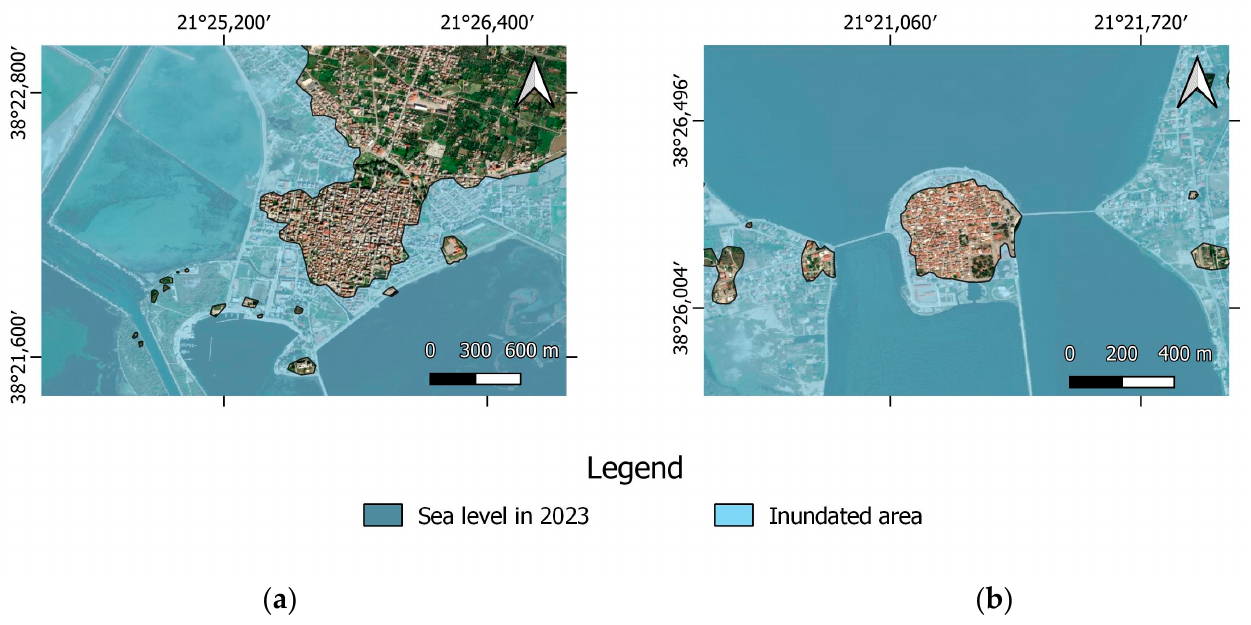
( b ) Figure 5. ( a ) Projected Mean Sea level change in coastal Greece according to RCP scenarios [71] ( b ). Projected Mean Sea level change at Messolonghi lagoon according to the SSP scenarios [72] The constant increase in the sea level has been causing a rush of seawater over the